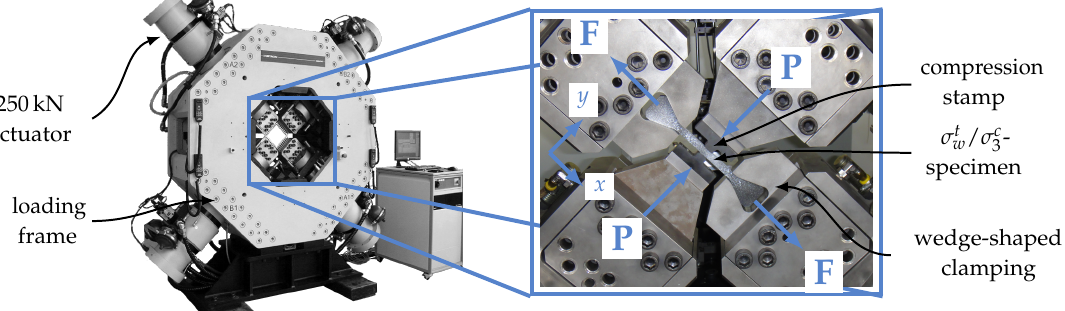
Figure 2. Planar biaxial servo-hydraulic testing machine I NSTRON 8800 and magnification of the σ t w / σ c -testing 3